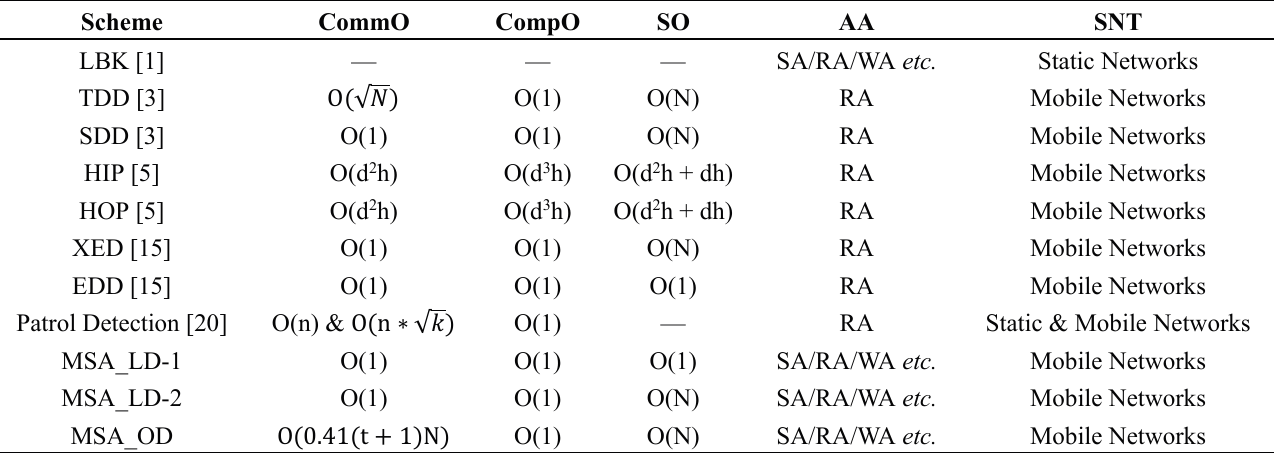
Table 1. Overhead of different schemes, CommO: Communication overhead; CompO: Computation overhead; SO: Storage overhead; AA: Against attacks: SA: Sybil attack; RA: Replication attack; WA: Wormhole attack; SNT: Supported network